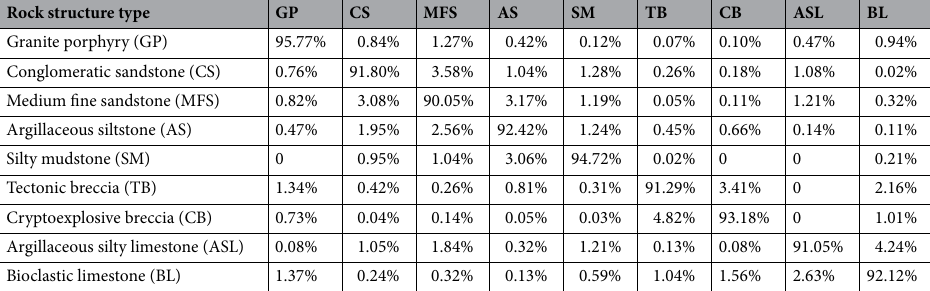
Table 4. Confusion matrix of classification results by SAFN model.